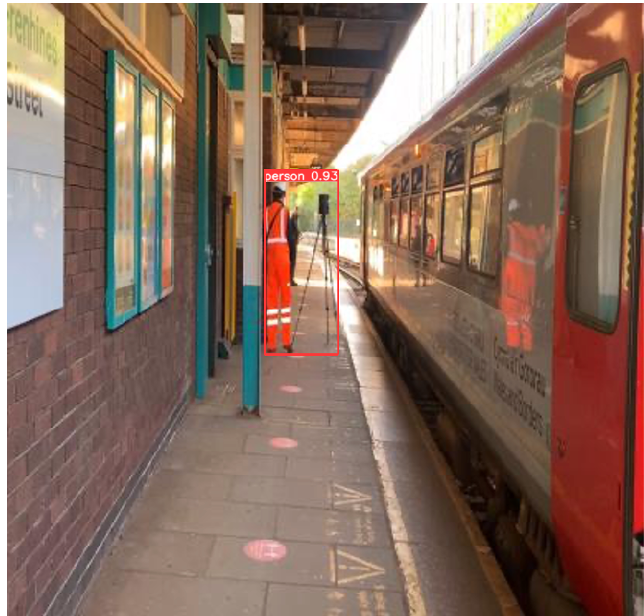
Figure 5. Detection results on YOLOR on custom